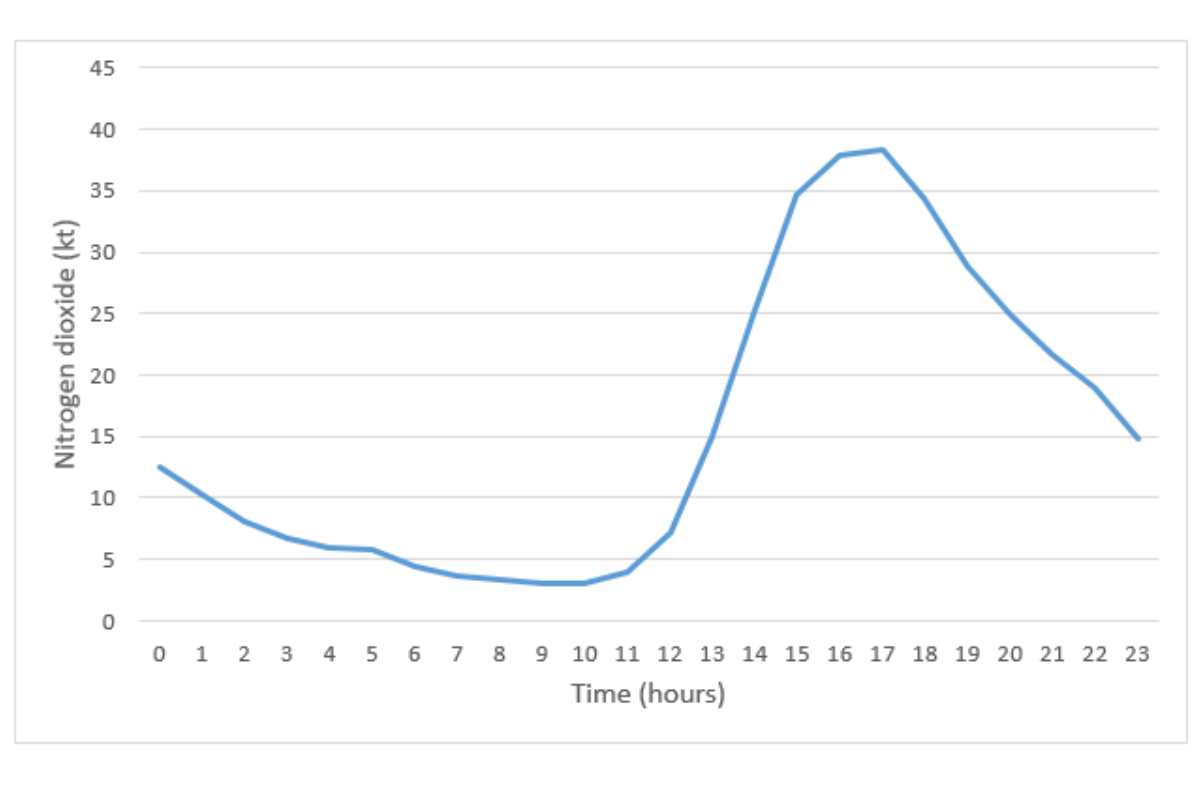
Figure 7: Mean annual diurnal variation of LNOx production over South Africa for the years 2008 to 2015.